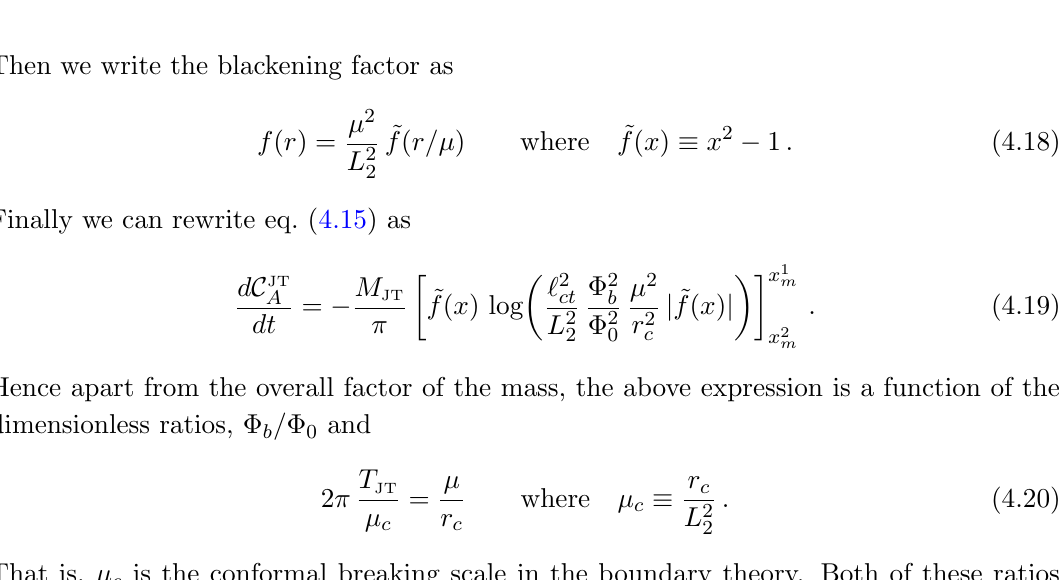
Figure 9 . Complexity growth in the JT model from eq. (4.19). Di(cid:11)erent colours correspond to di(cid:11)erent temperatures. We set (cid:8) b = 10 (cid:0) 3 and ‘ ct = L 2 . As we can see, the curves are qualitatively (cid:8) 0 similar to the purely magnetic curve in 2, with a negative transient behaviour, and the vanishing late time rate of